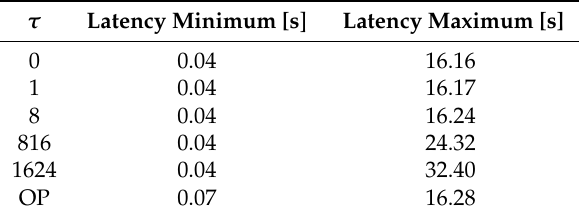
Table 2. Maximum and minimum theoretical latencies.